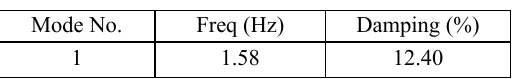
Fig. 8. Prony analysis using simulations of 7-bus test system. Table 1. Identified modes within frequencies between 0.1 and 2.5 Hz.